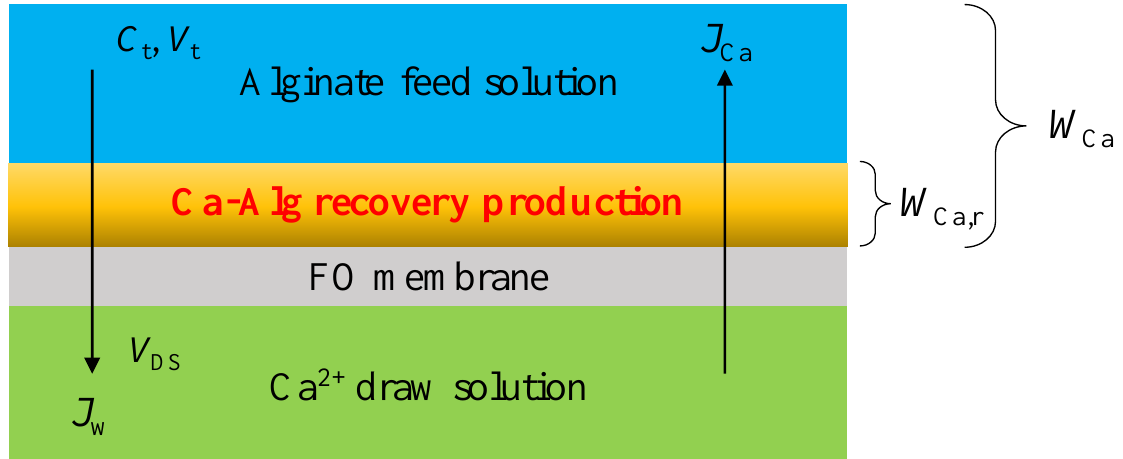
Figure 1. Mass transfer diagram in calcium alginate production via forward osmosis (FO) using reverse solute diffusion. Here, C t is the Ca 2+ concentration in the feed solution (FS) at time t ; V t and V DS are the volumes of the FS and the draw solution (DS) at time t , respectively; J w is the water flux passing through the FO membrane per unit membrane area per unit time at time t ; J Ca is the reverse solute flux (RSF) of Ca 2+ without considering Ca 2+ in the CARP passing through the FO membrane per unit membrane area per unit time at time t ; W Ca is the total content of reverse osmosis Ca 2+ including that in the CARP formed on the FO membrane at time t ; W Ca,r is the Ca 2+ content in CARP formed on the FO membrane at time t .